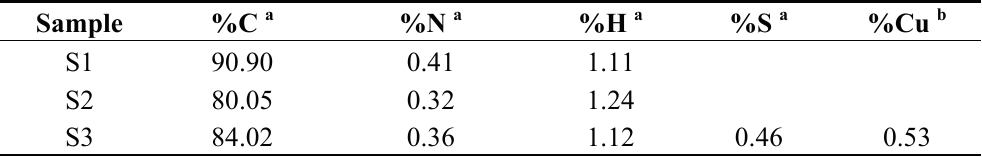
Table 1. Elemental analysis for the starting Starbon ® 700 (S1), brominated (S2) and with the CudiolPhBox complex anchored (S3).